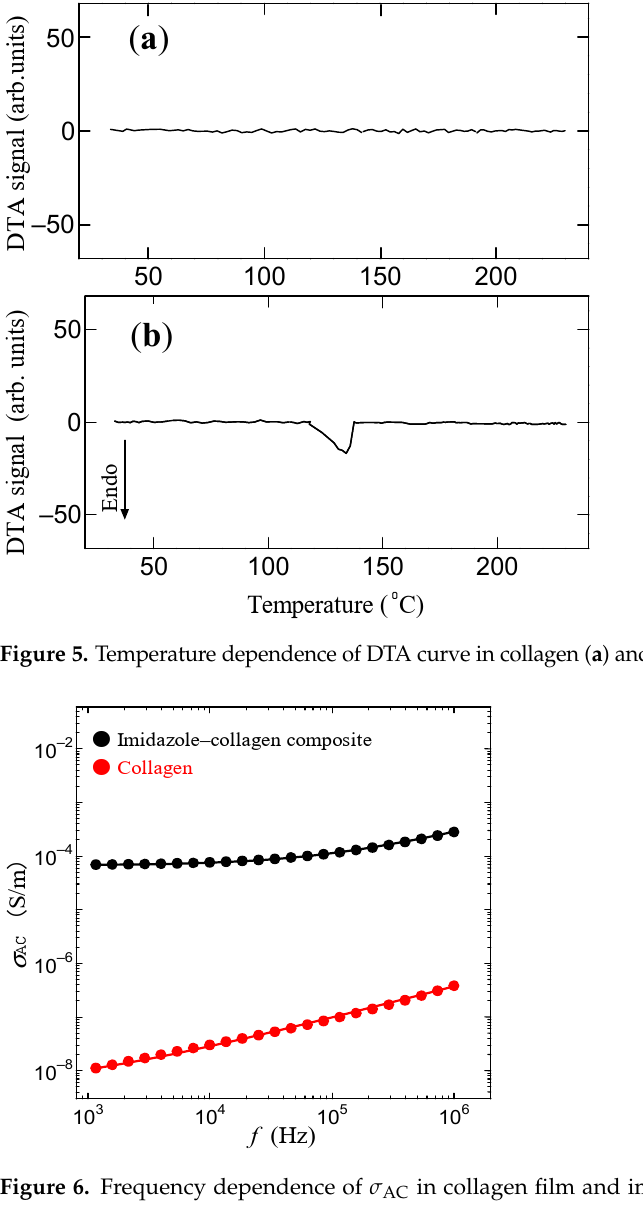
Figure 6. Frequency dependence of σ AC in collagen film and imidazole–collagen composite film ( n = 2.0).